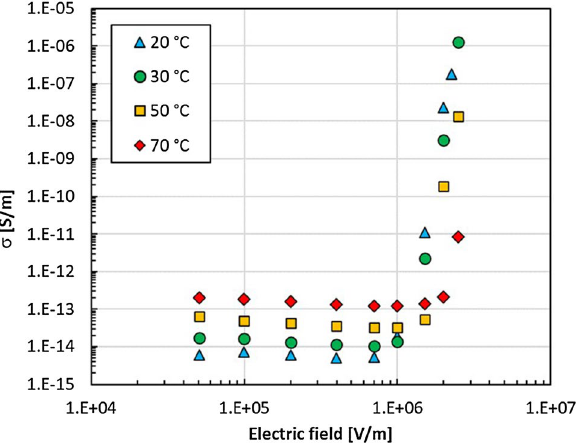
Figure 2. DC conductivity versus electric field at 20–70 °C for ZnO tetrapods in silicone